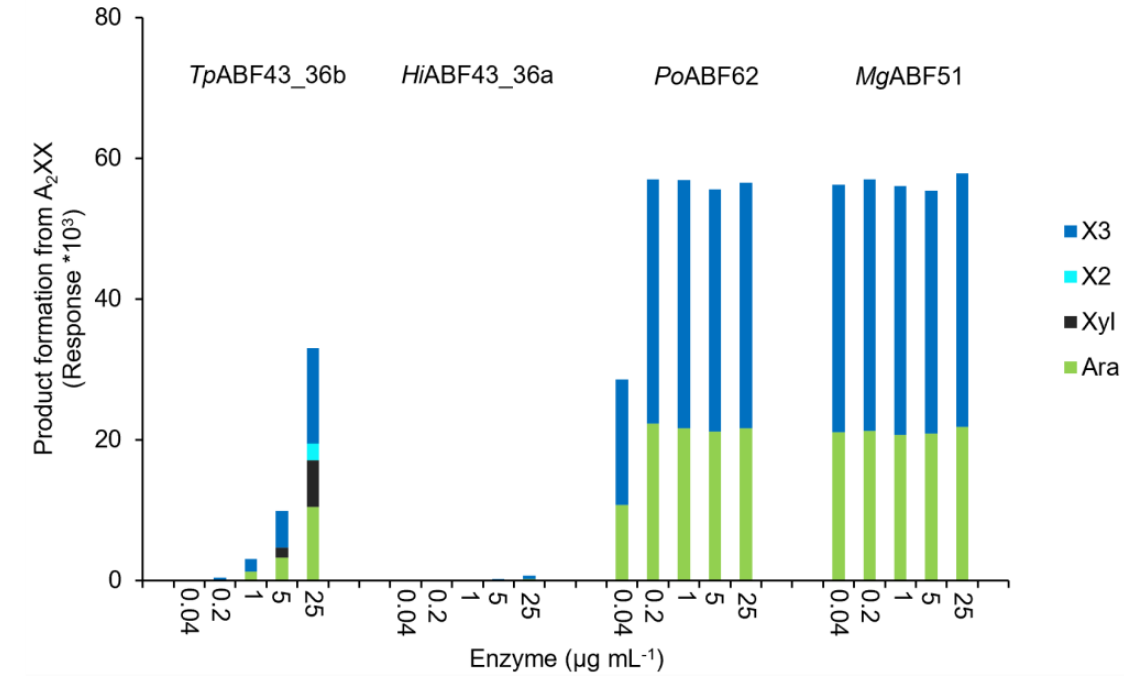
Figure 10. A 2 XX product formation (HPAEC) when incubated with Hi ABF43_36a, Tp ABF43_36b, Po ABF62, and Mg ABF51. Arabinose (Ara), xylose (Xyl), xylobiose (X2), and xylotriose (X3) were detected. Reaction conditions are displayed in Section 4.2.2, exp. # 2.